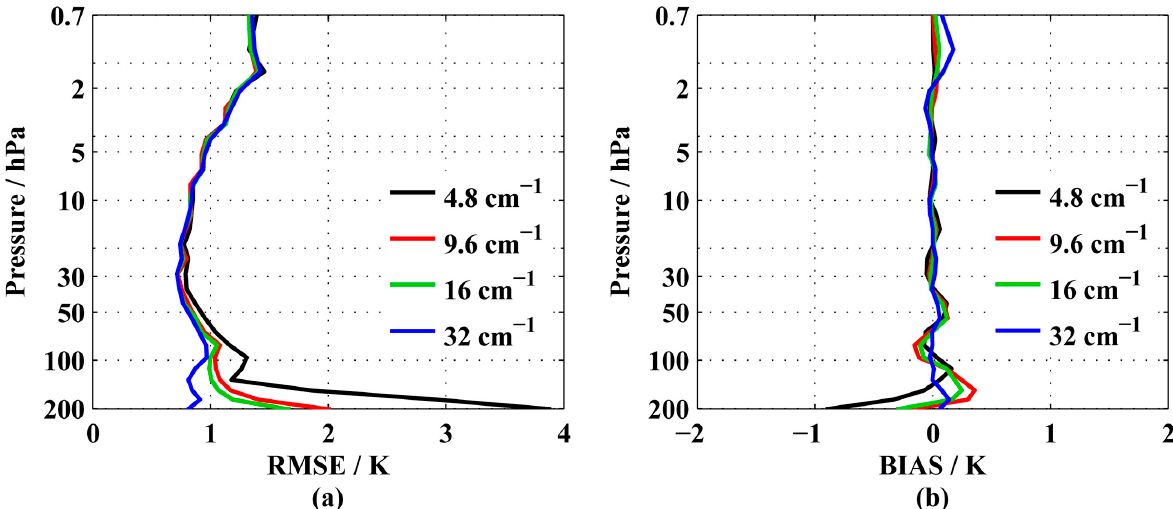
Figure 8. The variation of temperature Jacobian curves of the channels with the spectral resolution and the spectral region of 666.1–682 cm − 1 . ( a ) The channel of 668.4 cm − 1 . ( b ) The channel of 669 cm − 1 . ( c ) The channel of 671.1 cm − 1 .